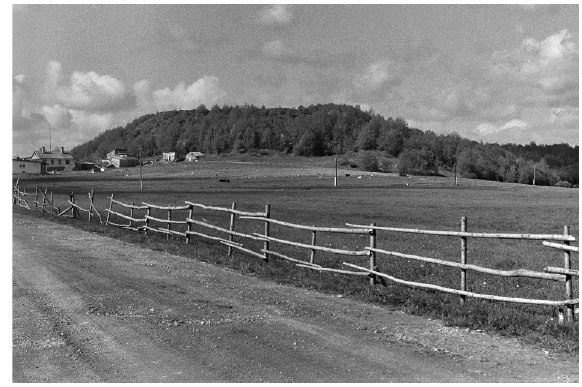
Fig. 6. A view of Pargimägi Hill. Photo by A. Miidel.